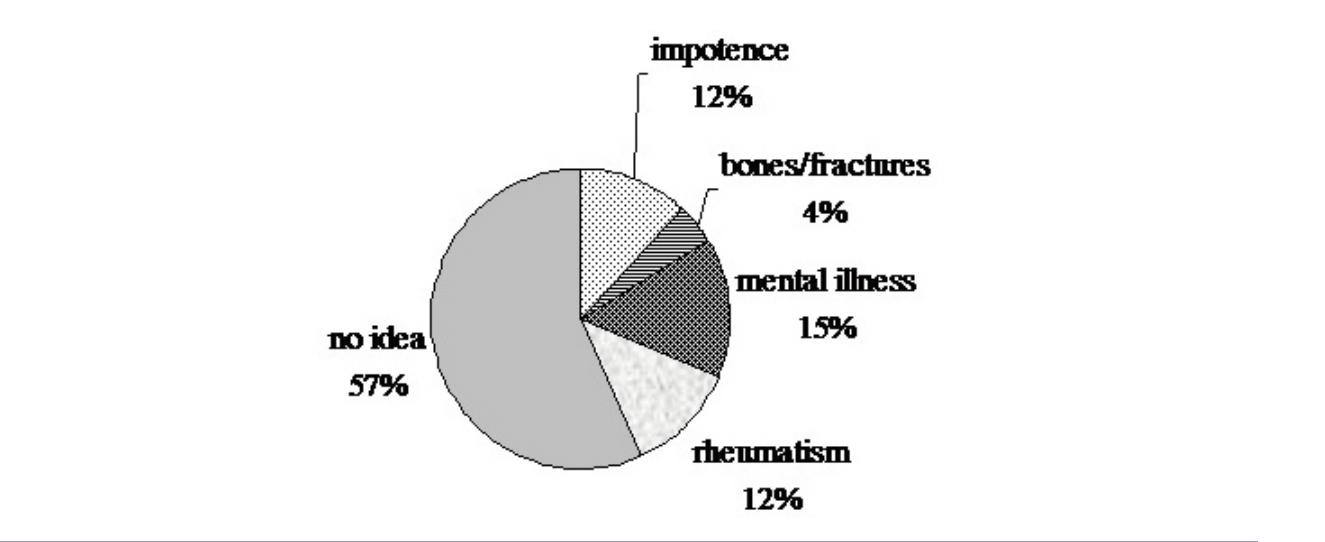
Fig. 4. Diseases reported to be cured by traditional medicines containing gorilla parts in five villages of Lebialem Division (percentage of all